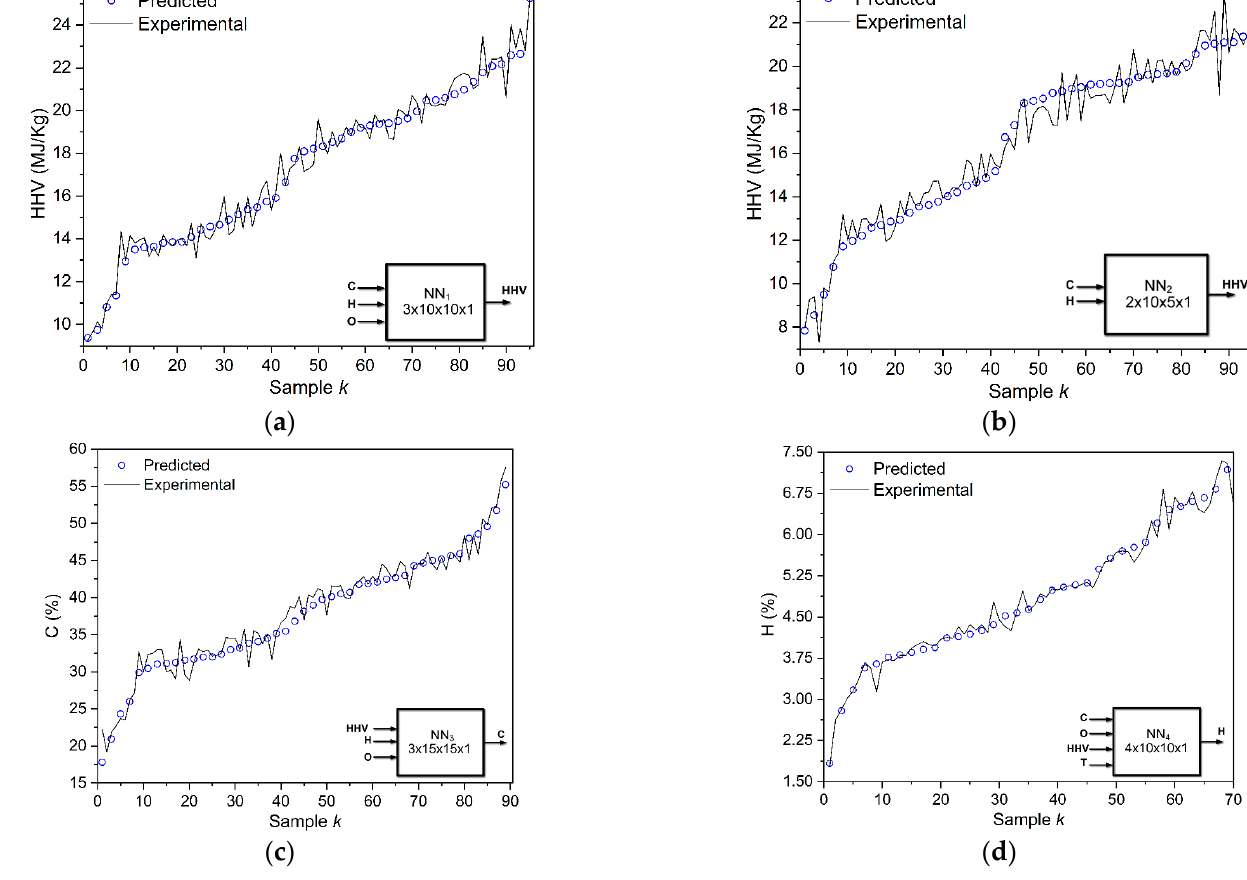
( a , b ), C pr ( c ), H pr ( d ) output biochar values. k k k